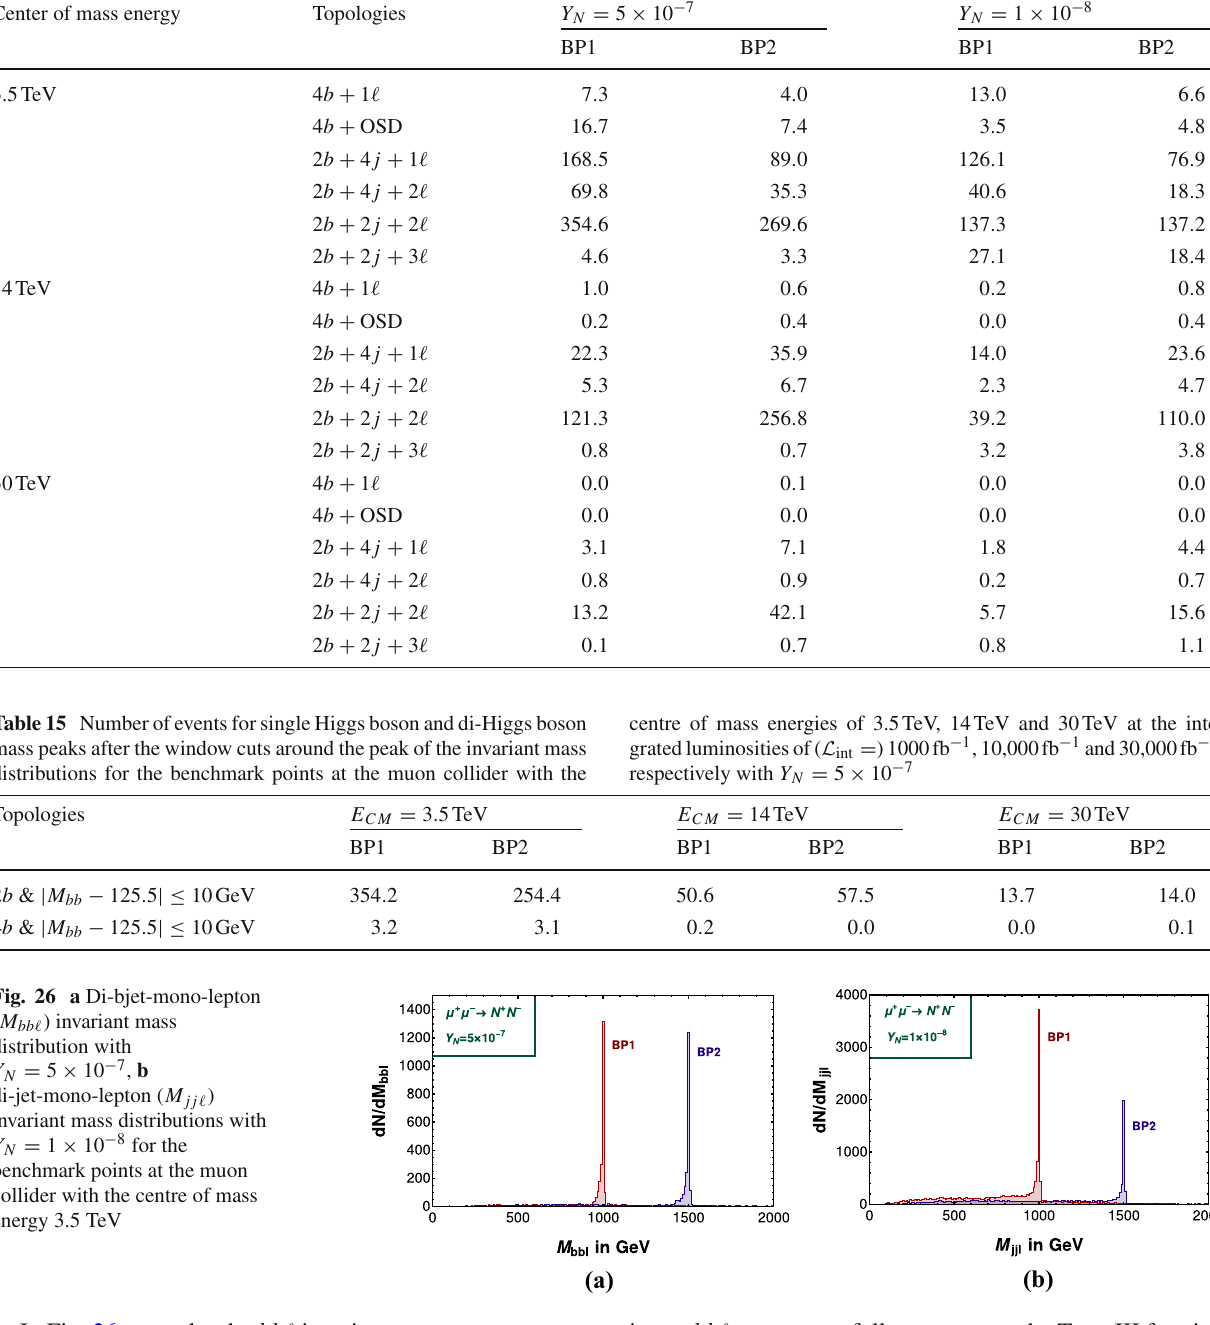
Table 14 Number of events for finalstate topologies containing at least two b -jets for the benchmark points with the centre of mass energies of 3.5TeV, 14TeV and 30TeV at the muon collider with integrated lumi-